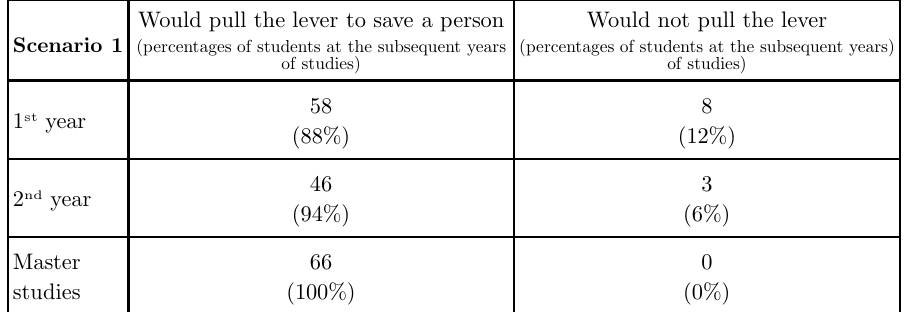
Results of Ill-informed Bystander , Bystander at the Switch , and Fat Man scenarios for the subsequent years of